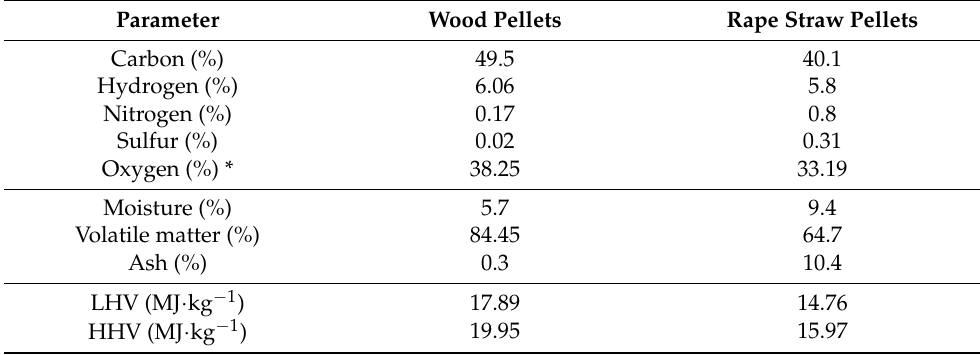
Table 1. Chosen characteristics of the tested